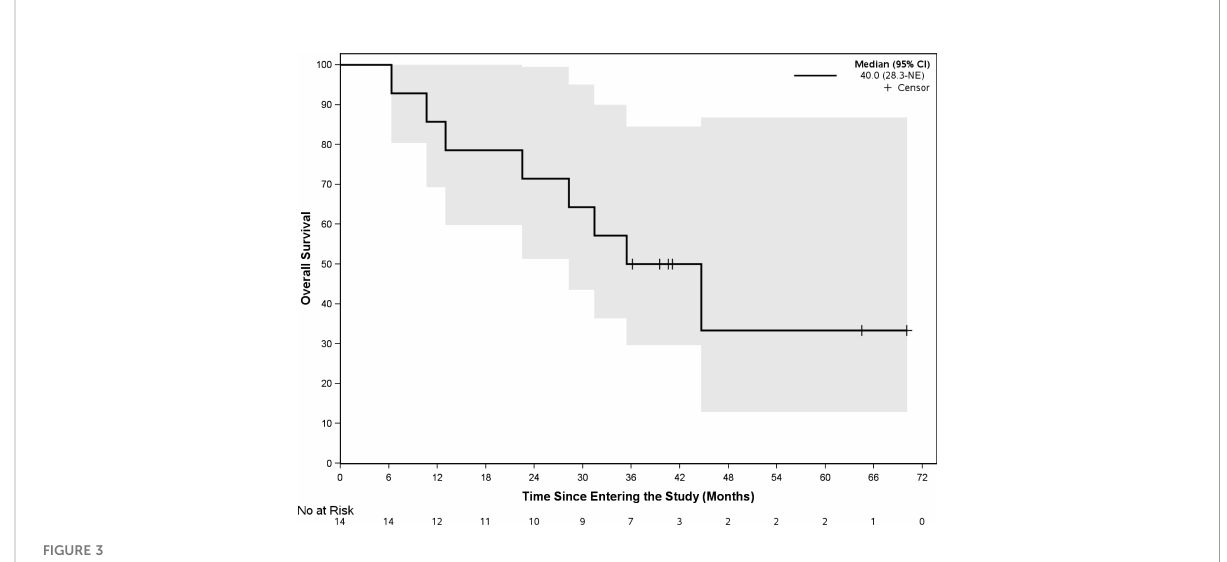
FIGURE 3 Kaplan-Meier survival curve of all evaluable